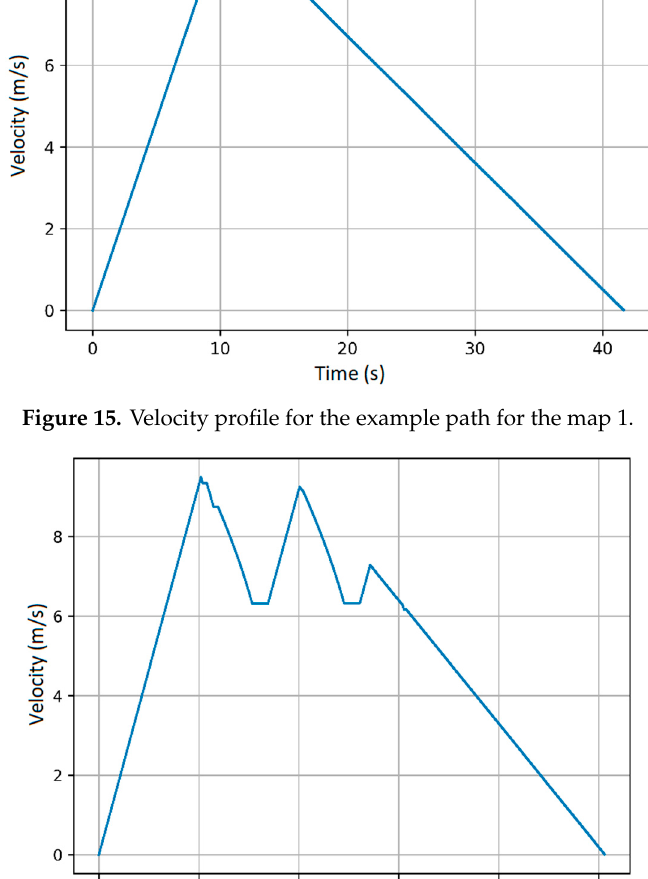
Figure 16. Velocity profile for the example path for the map 2.